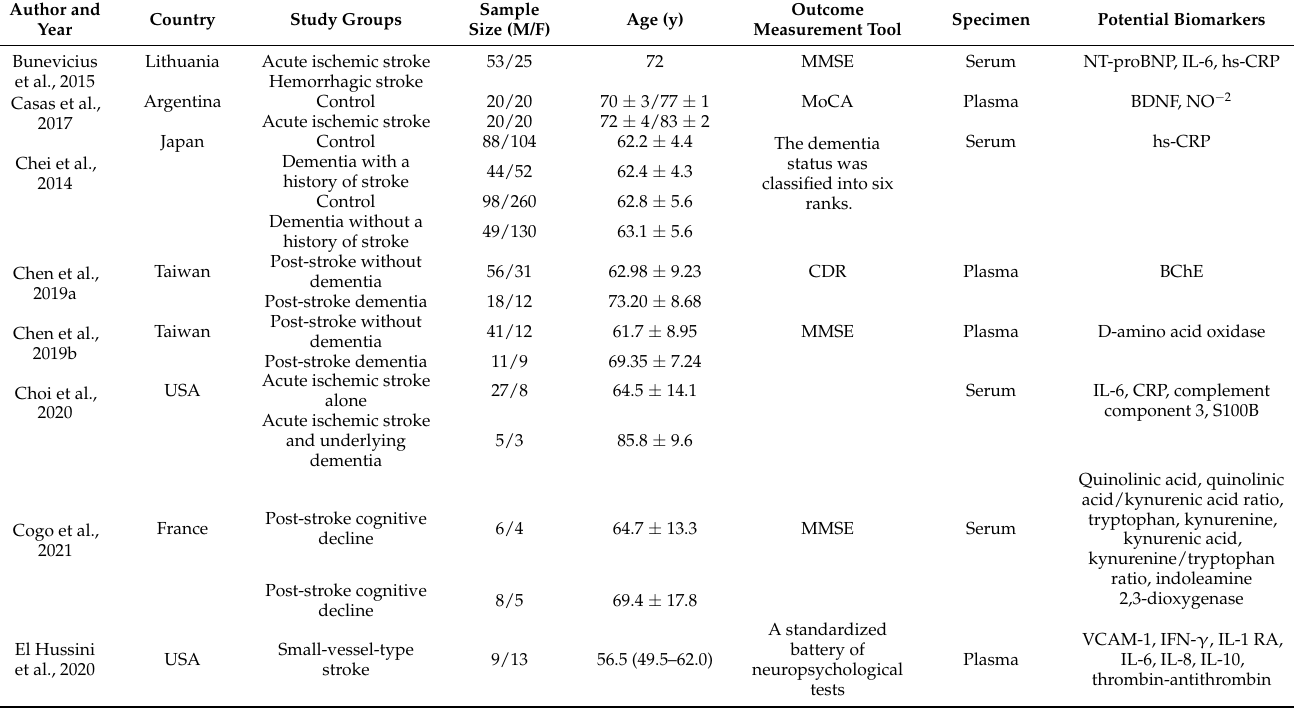
Table 1. Summary of the 40 selected studies reporting potential biomarkers for PSCI.